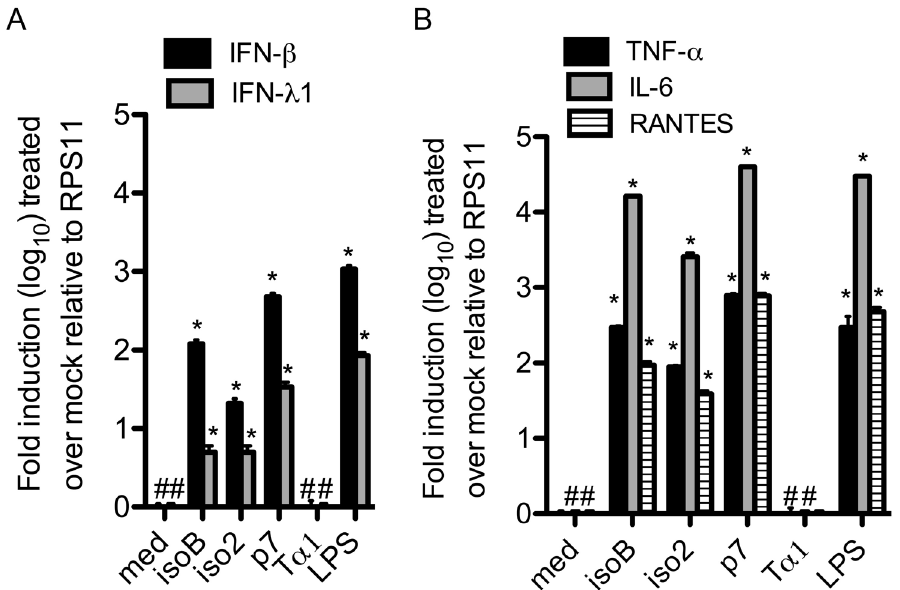
Fig 2. Up-regulation of mRNA of different innate inhibitors of viral replication in primary human macrophages treated with ProT α variants. A) INF- β and IFN- λ 1 and (B) TNF- α , IL-6 and RANTES mRNAs induction by ProT α variants. RT-qPCR with specific primers for indicated genes was performed as detailed in Methods on cDNA from primary human macrophages treated for 2 h with 200 ng/ml of ProT α variants or LPS. mRNA transcripts levels were normalized relatively to the expression of the ribosomal protein (RPS11) control mRNA. Each experiment was done at least three times. Data represent mean ± SD. Student ’ s t test was used to compare means of treated versus control samples. * P < 0.05 was considered to be statistically